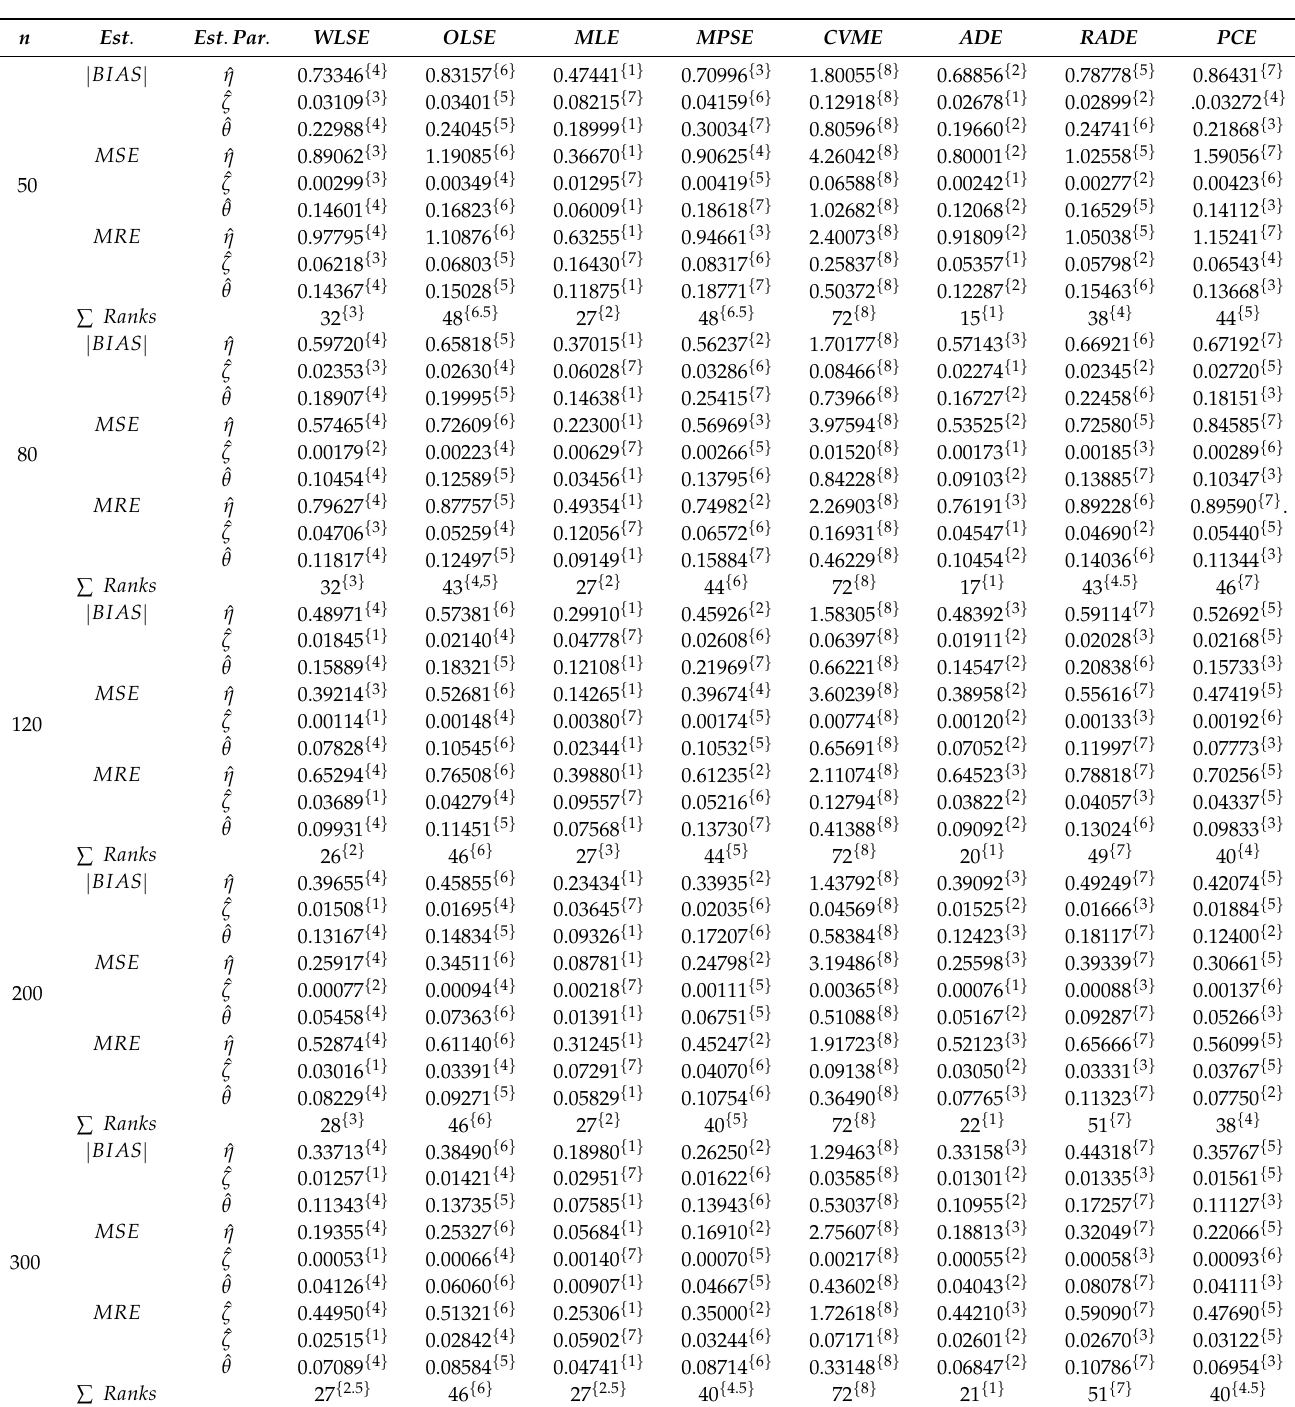
Table 5. Simulated results of the E-NPF distribution for Θ = ( η = 0.75, ζ = 0.50, θ = 1.60 ) T